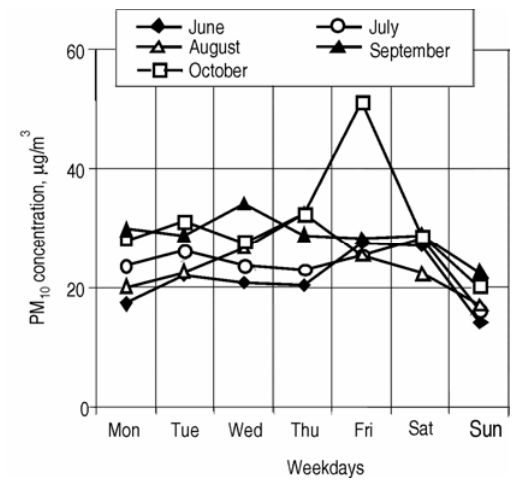
Fig 1 . Average daily variation of PM 10 concentrations in different